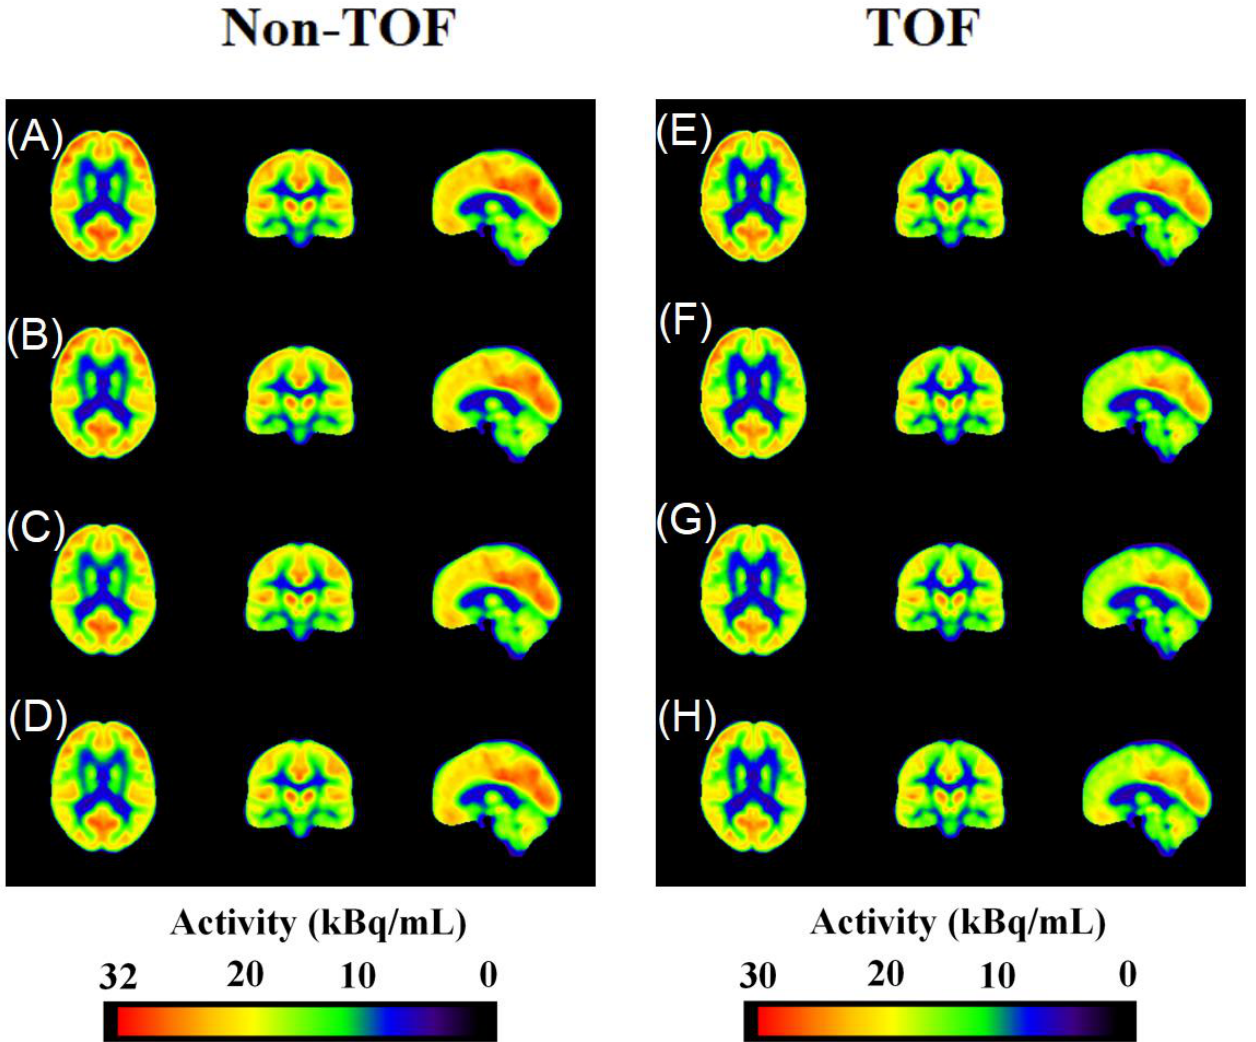
Figure 5. Mean PET images reconstructed with different attenuation maps compared between non- TOF and TOF reconstruction. A small benefit when using TOF reconstruction can be seen, although the visual differences are small. ( A ) CTAC, ( B ) 3 − class MRAC, ( C ) 2 − class MRAC, ( D ) 2 − class MRAC without air cavities using non-TOF reconstruction. ( E ) CTAC, ( F ) 3 − class MRAC, ( G ) 2 − class MRAC, ( H ) 2 − class MRAC without air cavities using TOF reconstruction.